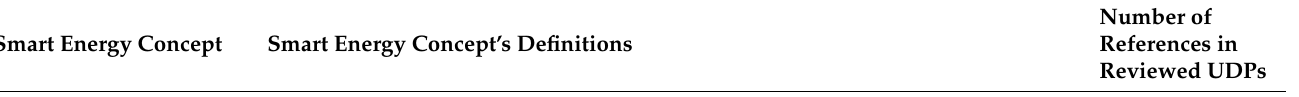
Table 2. A quantified overview of the Smart Energy conceptions and technologies referenced in the